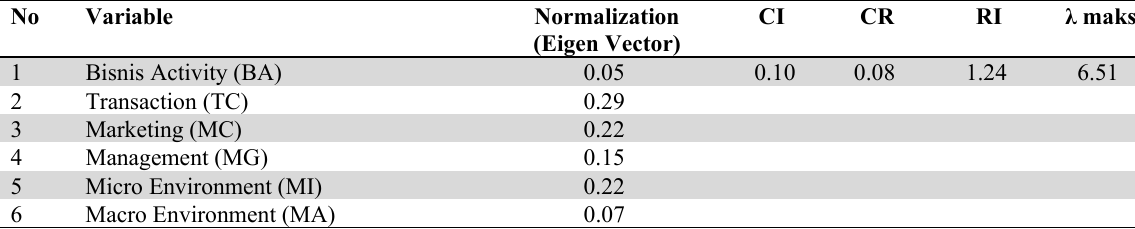
The recapitulation of AHP eigenvector